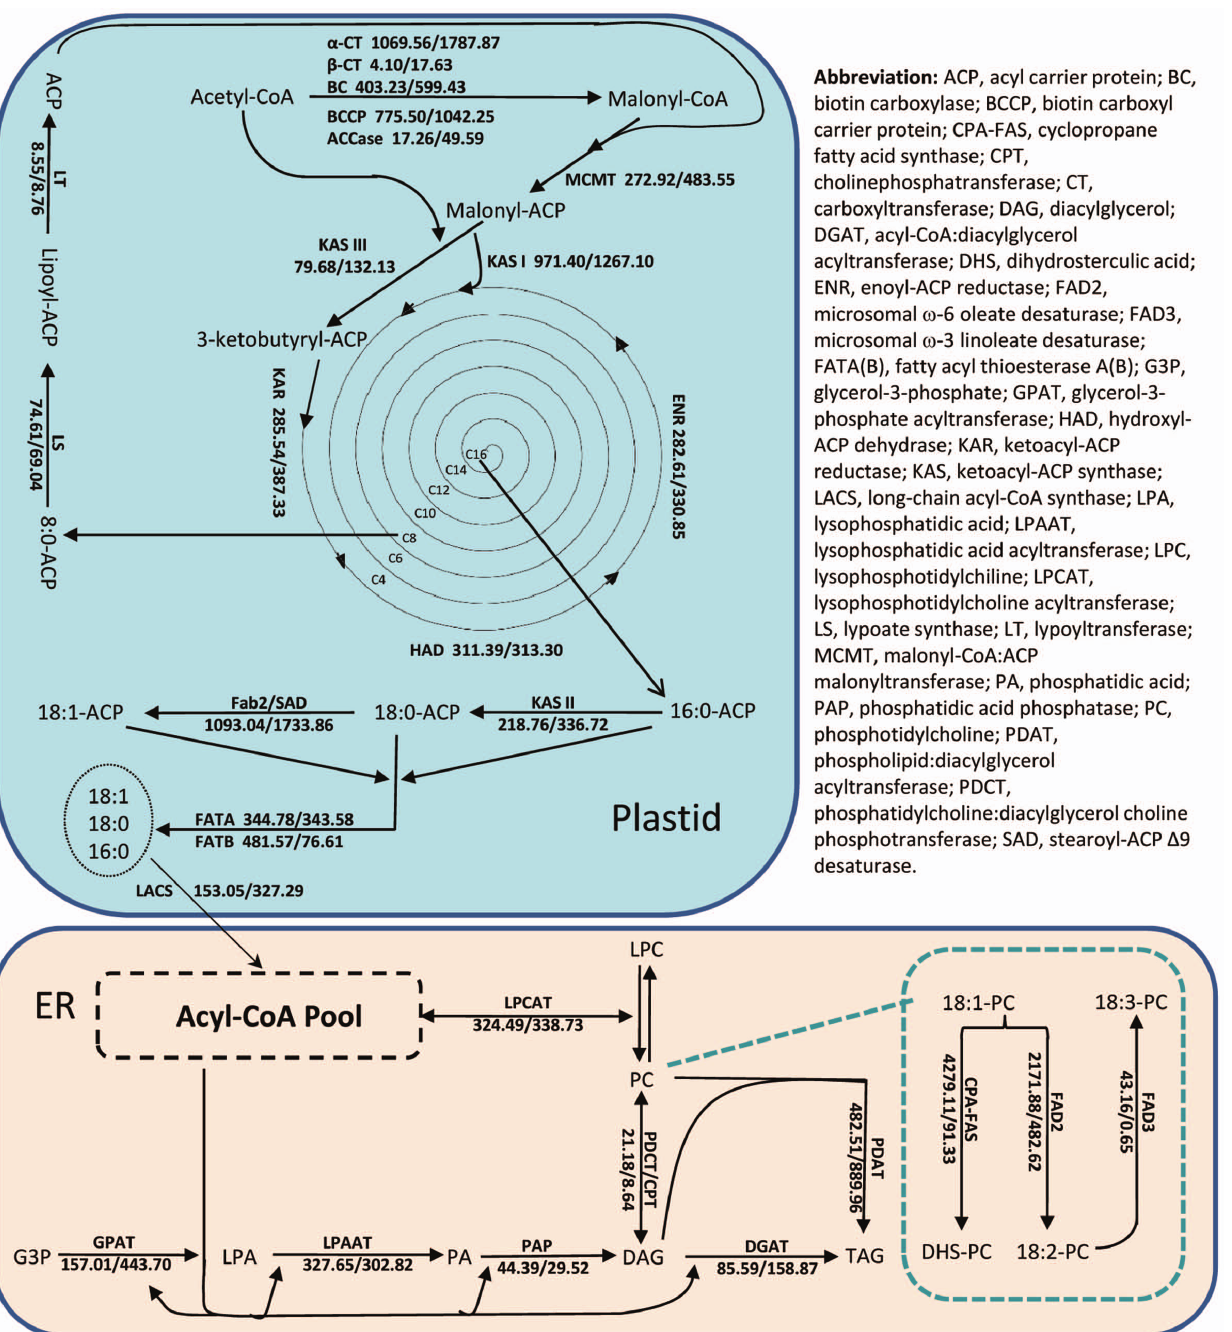
Figure 6. RPKM of unigenes in the transcriptome analysis for genes encoding enzymes in the fatty acid, TAG and oil body biosynthetic pathways in 30 DAP cotton embryo axis and cotyledon. The numbers after the gene (a/b) are the RPKM values for the corresponding genes in the transcriptome analysis of cDNA libraries: a, embryo axis; b, cotyledon.